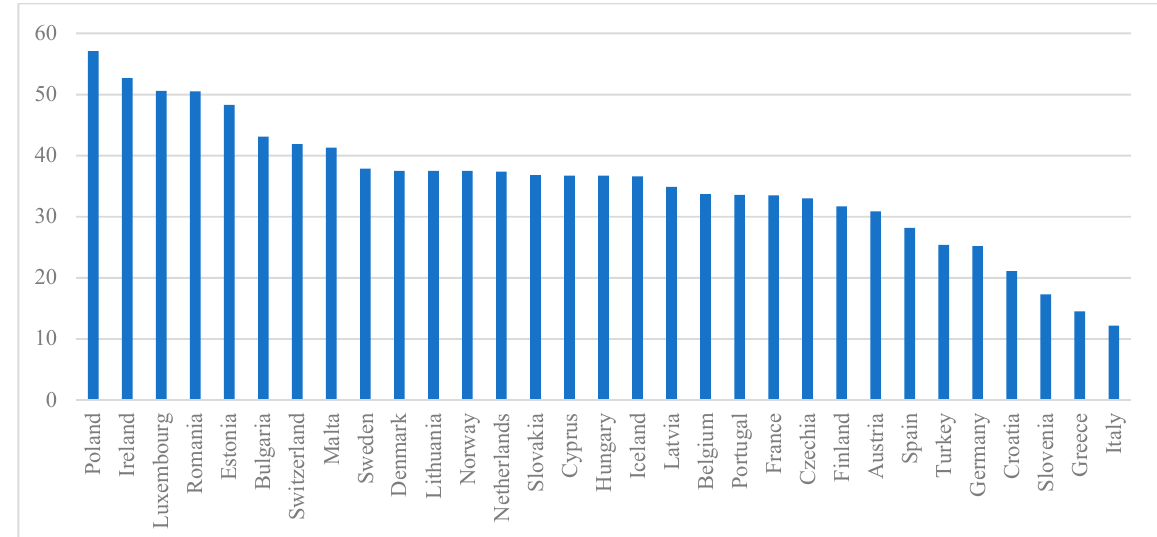
Figure 2. Immigrant population with tertiary education as percentage, 2020. Source: Eurostat (Population by educational attainment level). Note: Individuals with tertiary education and aged from 15 to 64 are covered in the figure. There is no data for UK in 2020.